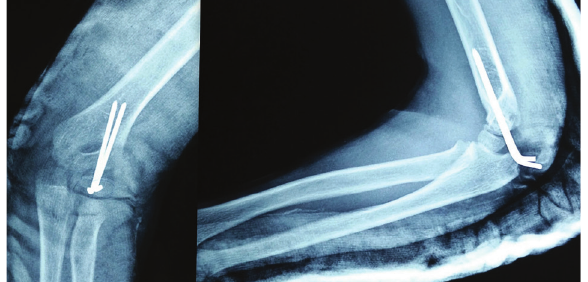
Figure 1. Radiography of elbow AP and lateral views showing postero-medial dislocation with fracture lateral condyle.